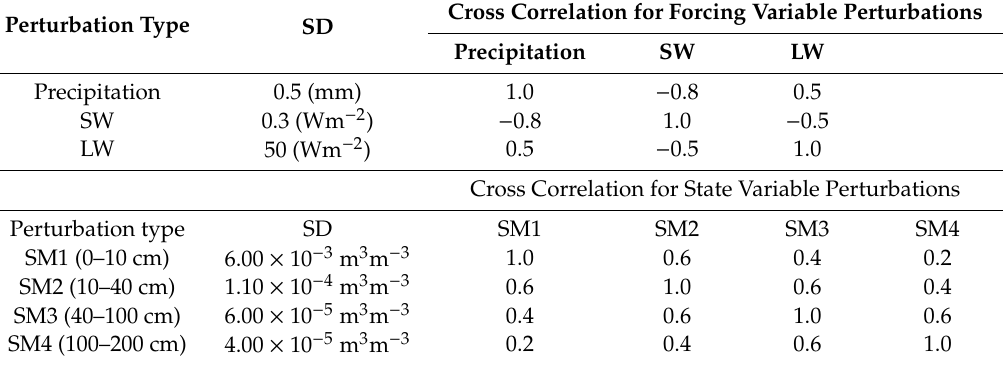
Table 1. Perturbations for state parameters and meteorological forcing variables [26,32]. The abbreviations SW and LW indicate short and long wave radiation. SD is standard deviation. The SM1, SM2, SM3, SM4 are 0–10 cm, 10–40 cm, 40–100 cm and 100–200 cm soil